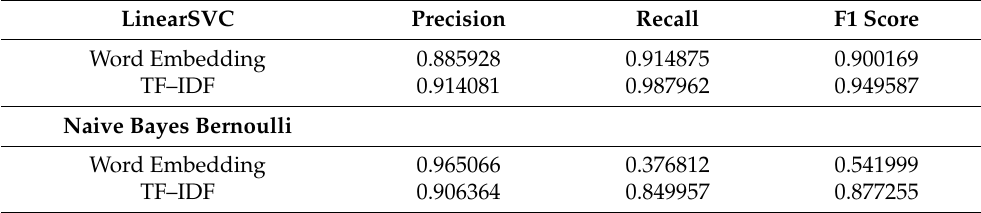
Table 1. Comparison of text vectorization methods.